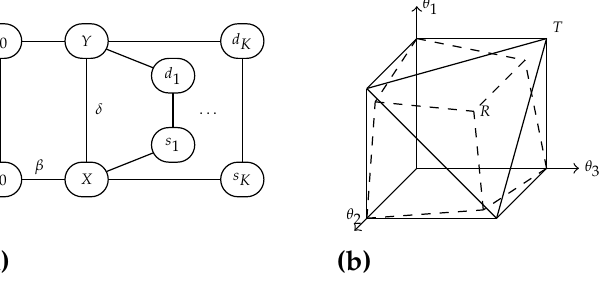
Figure 1. Directed graph (a) and polytopes T and R for K = 3 (b) Figure 2. Undirected graph ( a ) and polytopes T and R ( b ) illustrating the proof of Theorem 1 for Figure 2. Undirected graph (a) and polytopes T and R (b) illus- exploting high probability of congestion even for competitive K = 3. trating the proof of Theorem 1 for K = 3. ratio less than 2.